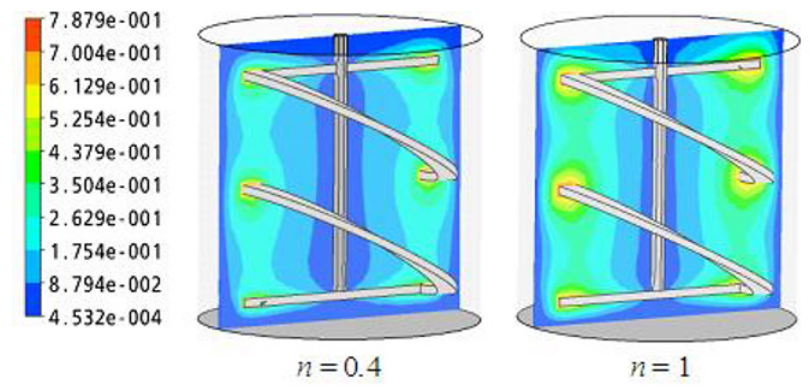
Figure 10. Flow field for double helical ribbon impeller, at Re